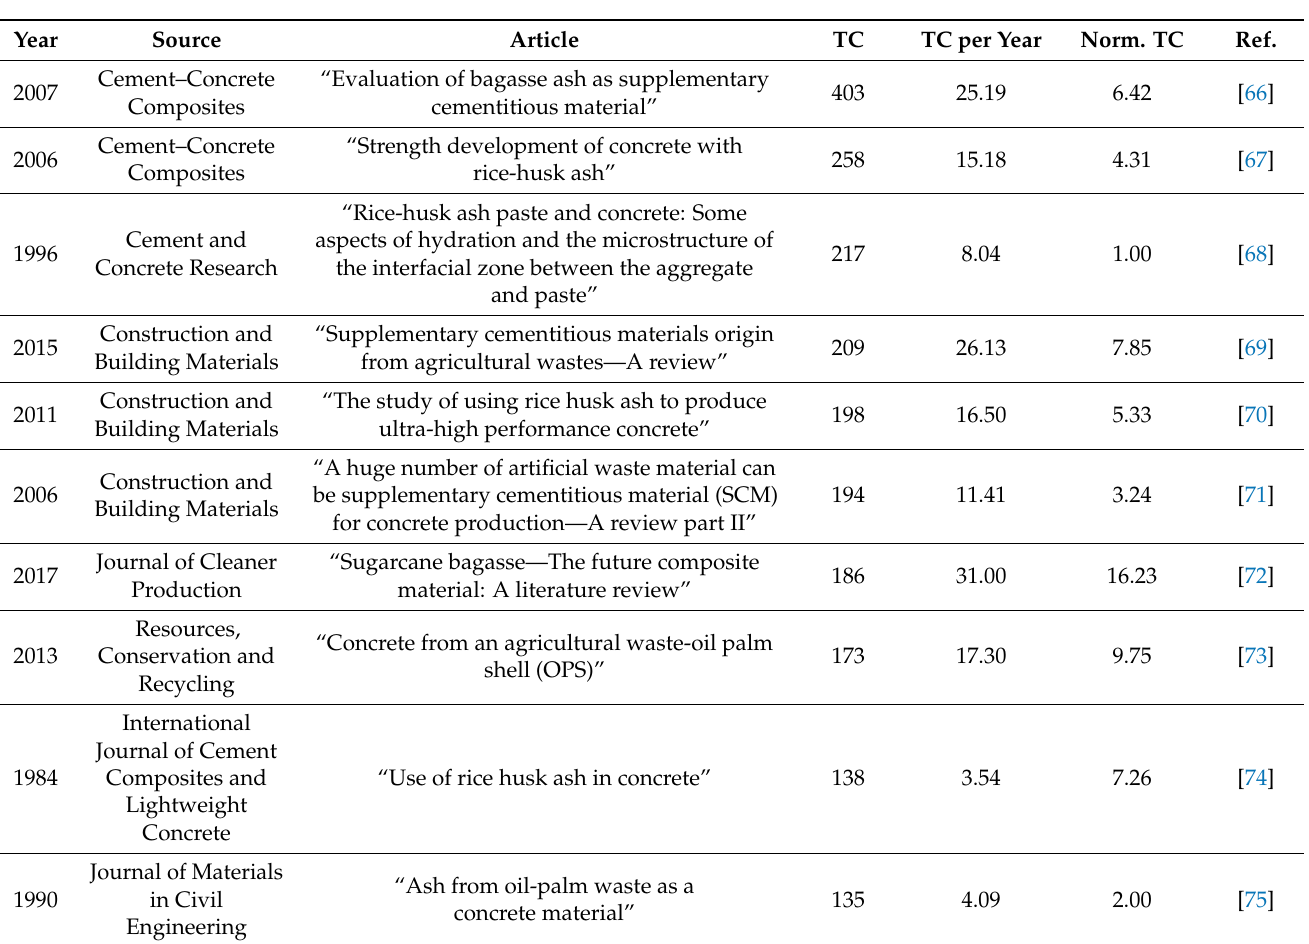
Table 5. Top 10 most globally cited